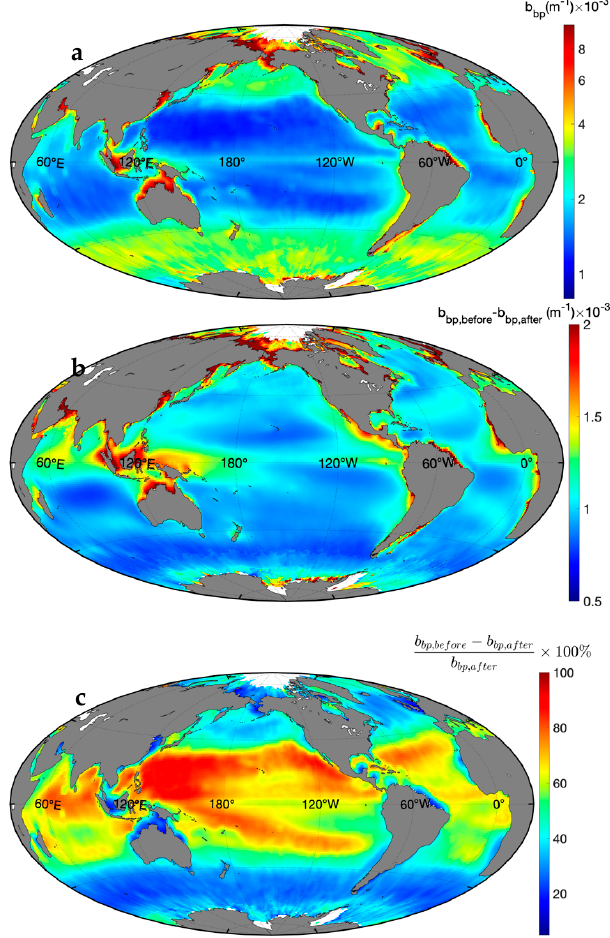
Figure 8. ( a ) Global distribution of the particulate backscattering coefficient b bp (m − 1 ) after the crosstalk correction. ( b ) Absolute differences of b bp (m − 1 ) before and after the crosstalk correction ( b bp , before − b bp , after ). ( c ) Relative differences of b bp before and after crosstalk correction ( b bp , before − b bp , after × 100%). Data are climatological annual averages for the 2008–2020 period and have been averaged to 1° latitude × 1° longitude pixels.